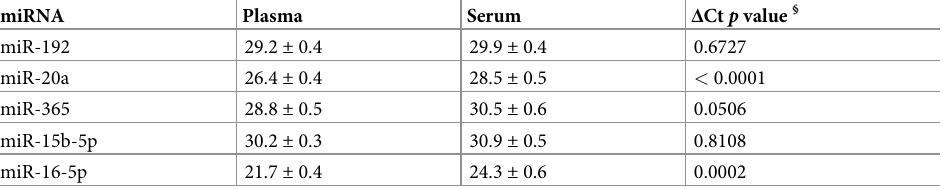
Table 4. Cycle threshold values (mean ± SEM) for microRNA derived from feline plasma and serum samples of the control group.